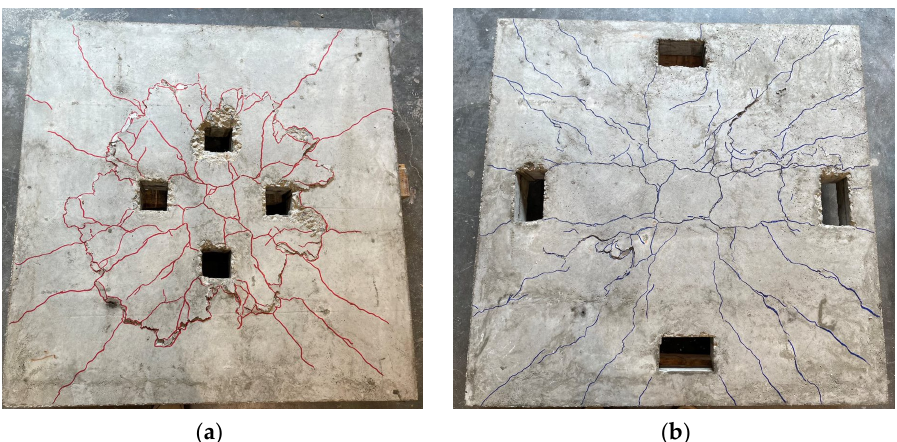
Figure 11. Crack patterns at failure for group 2 (Actual photos). ( a ) Specimen 4S1H; ( b ) Specimen 4R4H.